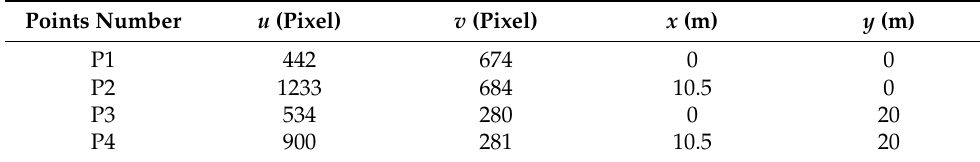
Table 3. Correspondence between two coordinate systems.